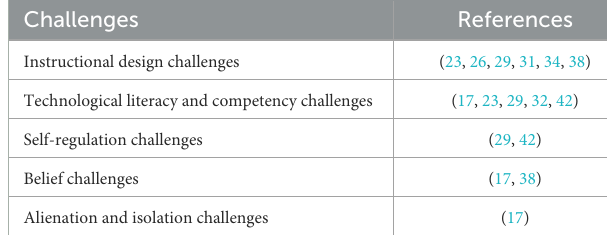
TABLE 3 The challenges of blended learning in physical